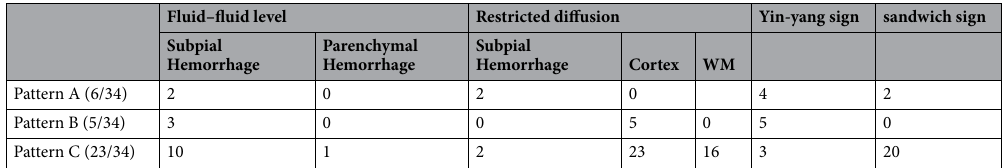
Table 3. MR imaging features of subpial hemorrhage in